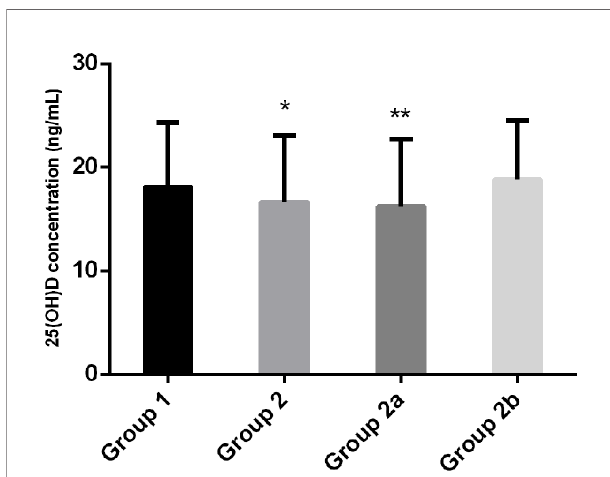
FIGURE 1 | Vitamin D levels in patients with type 2 diabetes and normal testosterone levels (Group 1), patients with type 2 diabetes and hypogonadism (Group 2; hypogonadotropic hypogonadism [Group 2a] and hypergonadotropic hypogonadism [Group 2b]). Data are expressed as